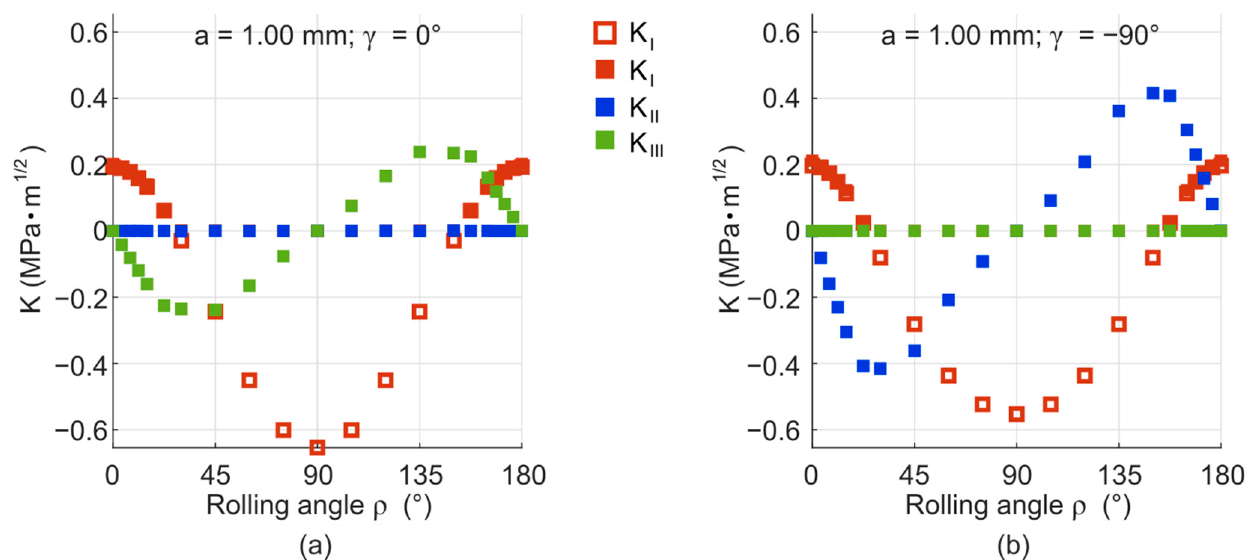
Figure A8. Course of stress intensity factors during rotation in the cylinder D × L = 6 × 6 mm 2 , load F = 350 N, a = 1.00 mm, position on the crack front; ( a ) γ = 0°; ( b ) γ = − 90°. Model including friction.